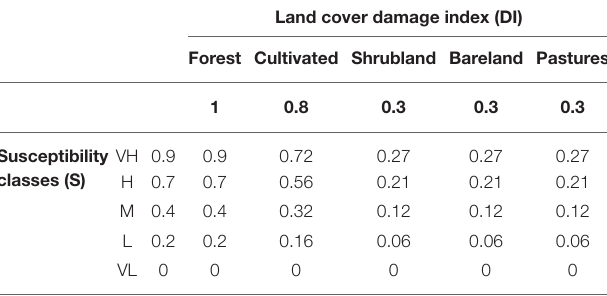
TABLE 3 | Matrix used to correlate the land cover damage index (DI) and the susceptibility classes indexes (S). Land cover damage index (DI) Forest Cultivated Shrubland Bareland